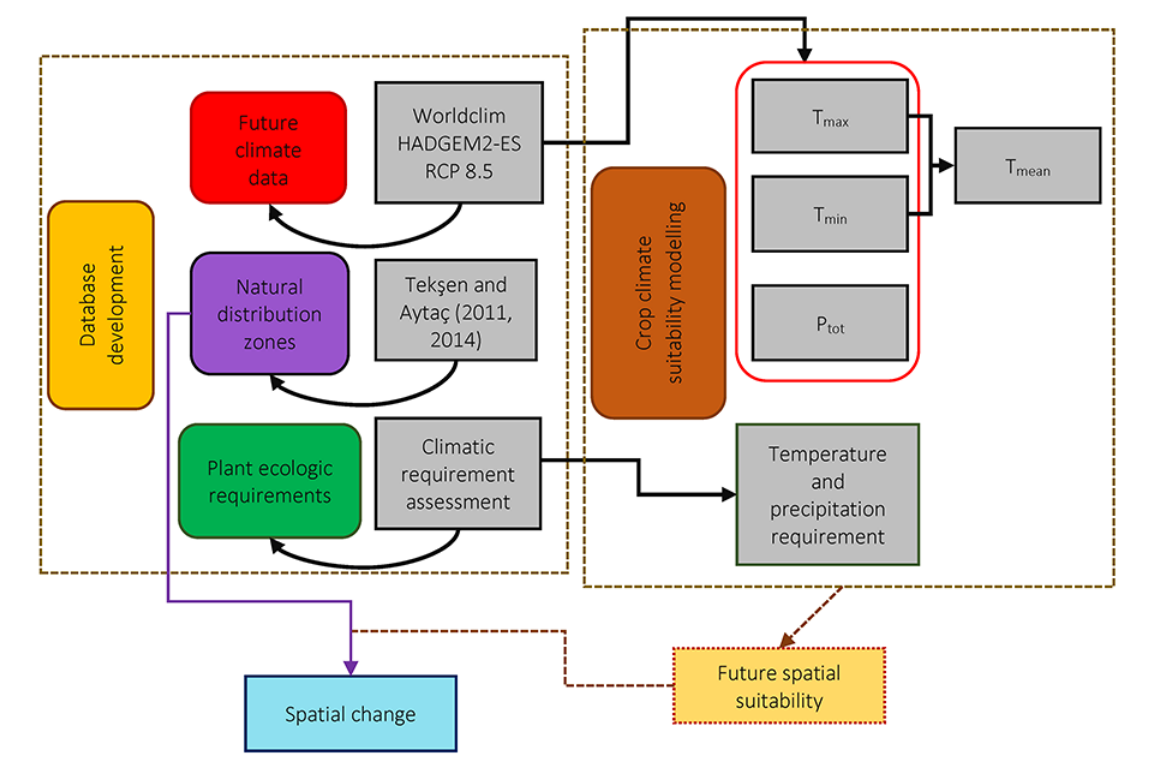
Figure 3 e methodological frame of the “future” plant climate suitability model. ActaSocietatisBotanicorumPoloniae / 2022 / Volume 91 / Article 919 Publisher: Polish Botanical